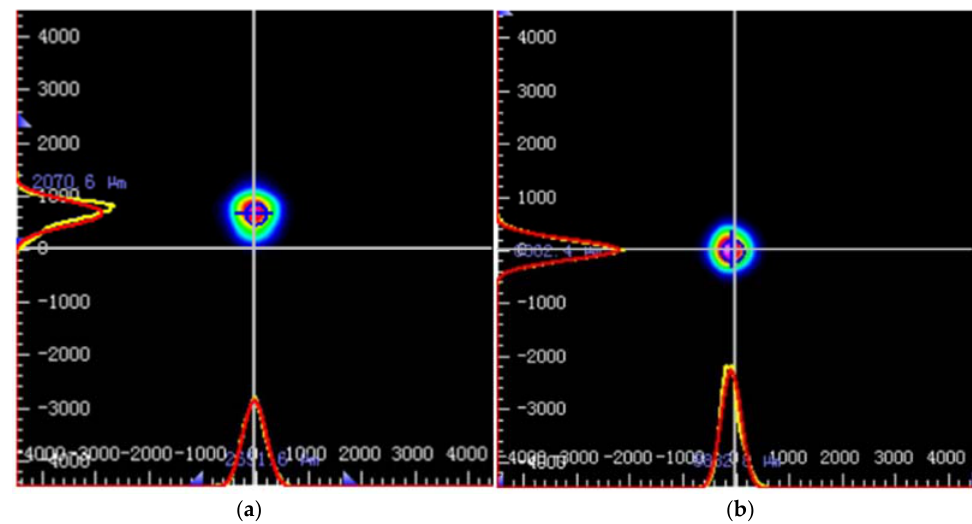
Figure 9. Beam quality of 2D. The horizontal axis and the vertical axis are the spatial coordinates of the 2D beam analyzer, and the (0,0) is the central point. The horizontal axis represents the direction of θ ∥ , and the vertical axis represents the direction of θ ⊥ . The color represents the energy. ( a ) is the beam quality of 2D with the central point offsetting (0,0) because the chip is bonded within the tolerance. ( b ) is the beam quality of 2D without the central point offsetting.